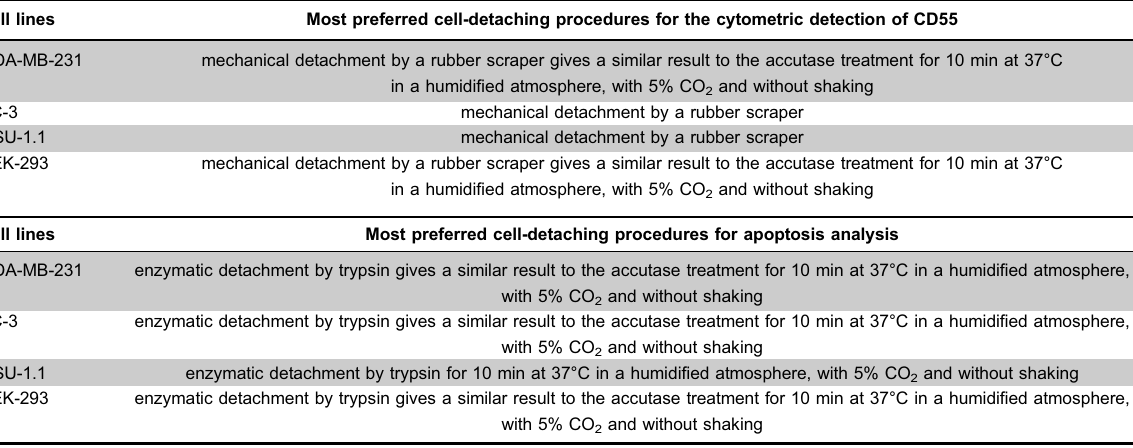
Table 1. Most preferred cell-detaching techniques for detecting cell surface proteins and apoptotic markers for different cell lines. Cell lines